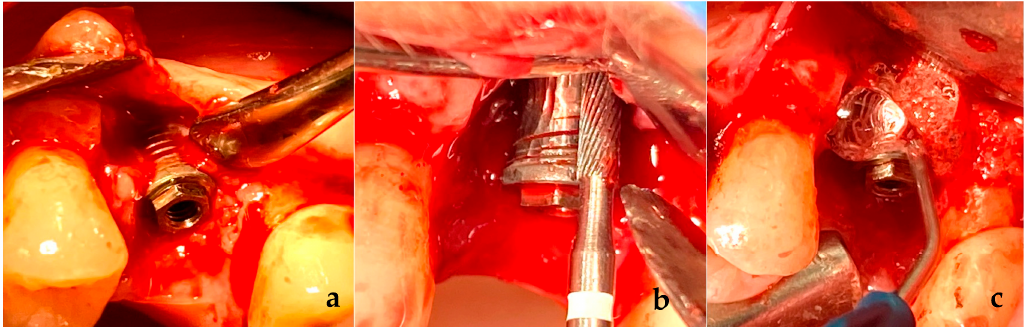
ical decontamination with diamond burs and irrigation with HClO. ( c ). Application of 6% H 2 O 2 , leaving it to act for 1 min, and then washing with HClO as an additional decontaminating